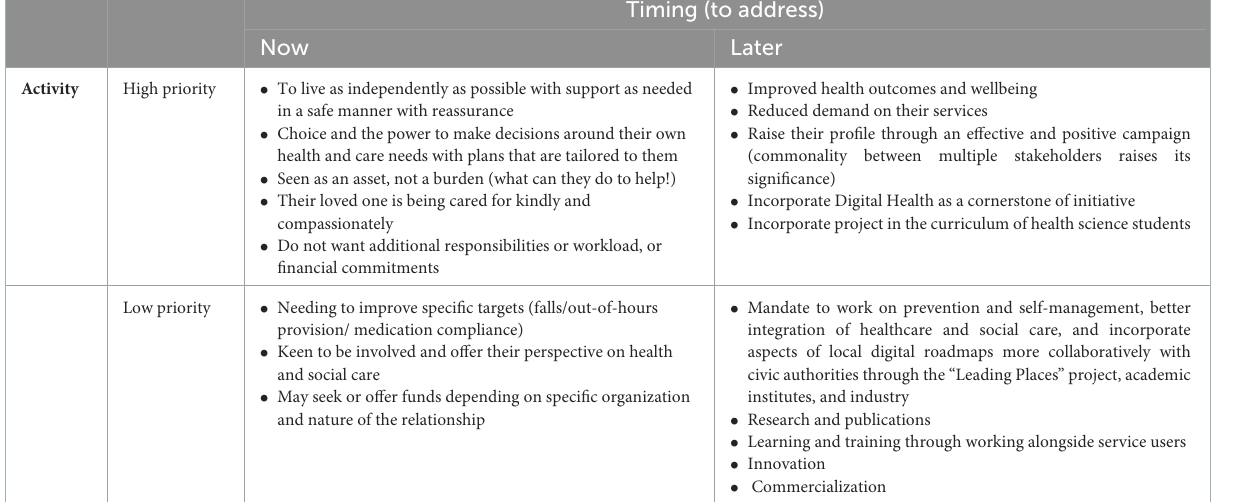
TABLE 2 Prioritization of stakeholders’